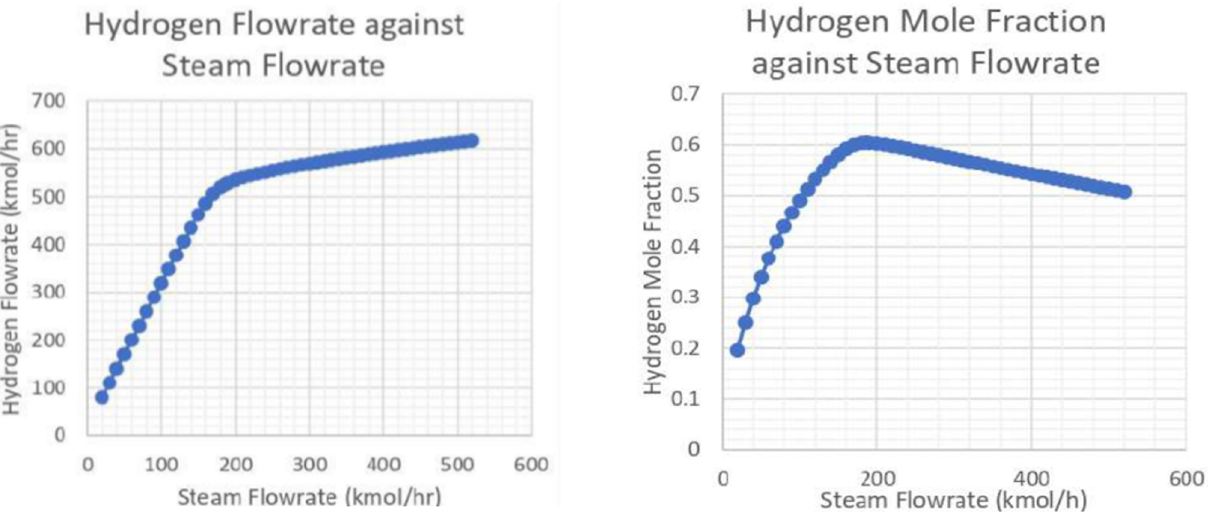
Figure 6. Sensitivity Analysis of steam flow rate.